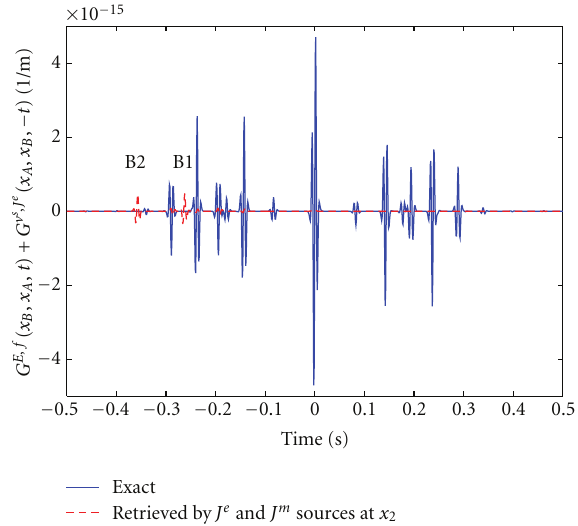
Figure 17: Comparison between the exact Green’s function G E , f ( x B , x A , t ) + G v s , J e ( x A , x B , − t ) and the Green’s function retrieved by considering only electromagnetic boundary source contribu- tions ( J e and J m ) in the right-hand side of (52). In other words, the contributions of the domain sources and seismic boundary sources are neglected. As is visible, the electromagnetic boundary sources have a negligible contribution to the retrieved Green’s function in the positive time window G E , f ( x B , x A , t ). However, the electro- magnetic boundary sources do contribute to the Green’s function retrieval in the negative time window, that is, G v s , J e ( x A , x B , − t ). The two red-dashed peaks at roughly t = − 0 . 28 s and t = − 0 . 38 s correspond to the spurious events B 1 and B 2, respectively. It is visible that the spurious events are not present in the exact case. The contribution of the electromagnetic boundary sources in cancelling out the spurious events in the negative time window is clearly